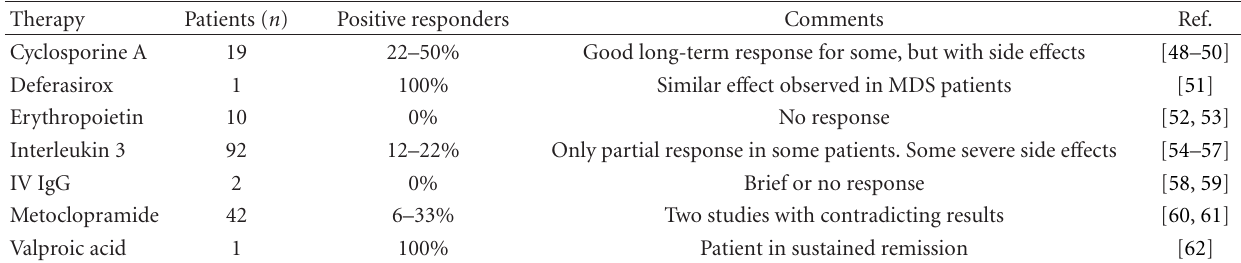
Table 1: Compounds clinically tested as new DBA treatments and their respective